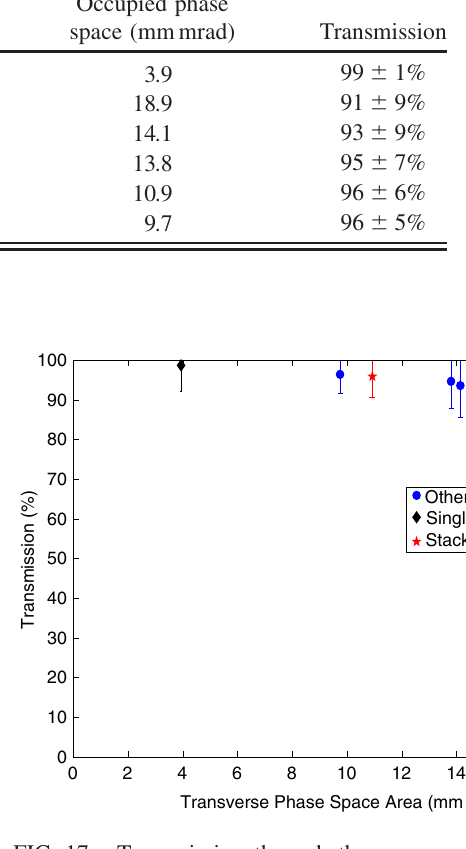
FIG. 17. Transmission through the ramp as a function com- bined beam horizontal emittance. The black diamond shows the single beam case, the red star shows scenario 4, the specification for beam